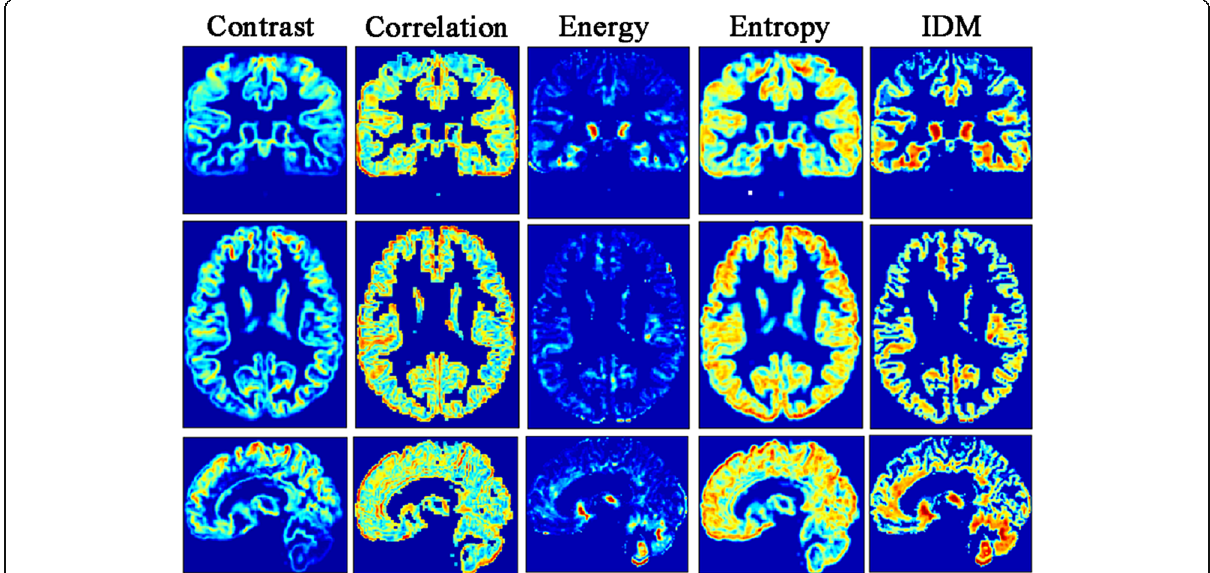
Fig. 2 The texture features maps. 1 st column, Contrast map; 2nd column, Correlation map; 3rd, Energy map; 4th, Entropy map; 5th, IDM map